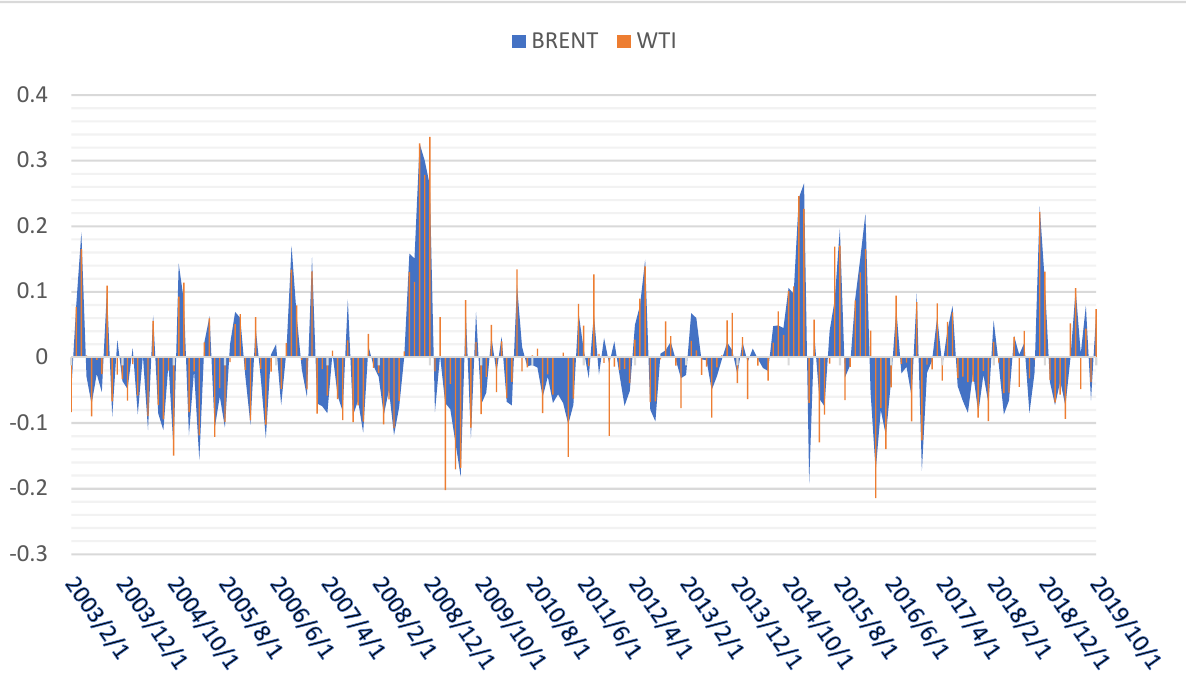
Figure 1. Brent and WTI Monthly Log Returns.